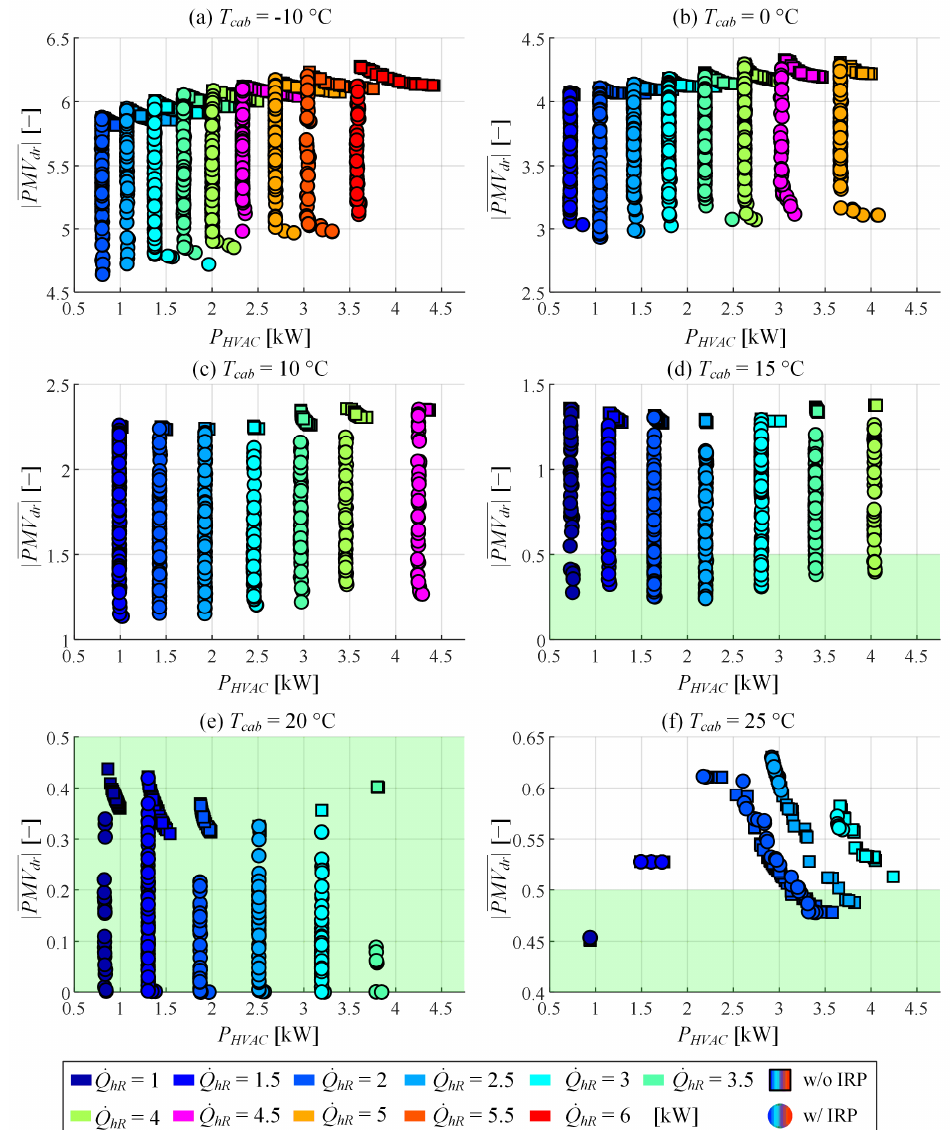
Figure 6. Pareto frontiers expressed in terms of HVAC-only power consumption for cases with (circles) and without use of IRPs (squares) at different cabin temperatures ( a – f ).